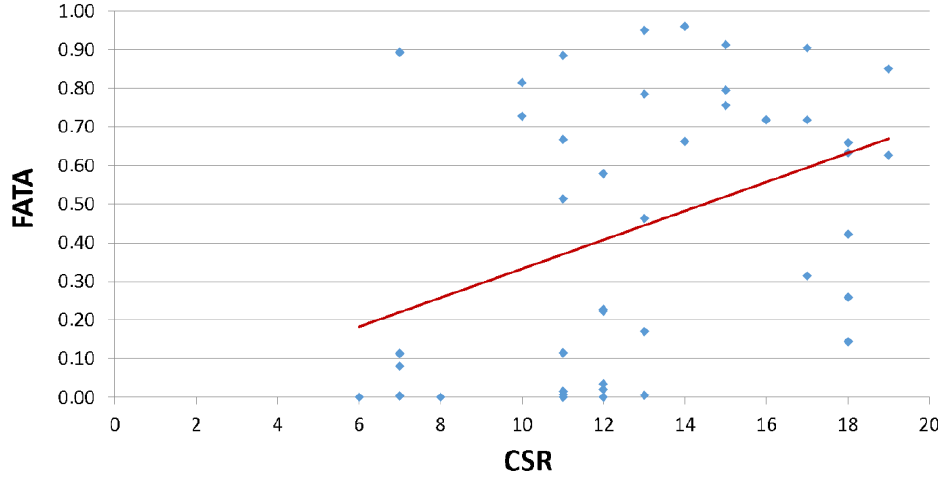
Figure 2. Relationship between CSR and FATA (Foreign Assets over Total Assets).